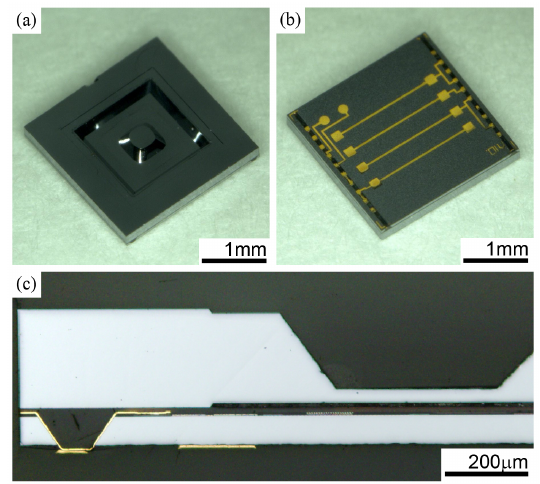
Figure 7. Prototyped tactile sensor: ( a ) front; ( b ) back; and ( c ) cross sectional